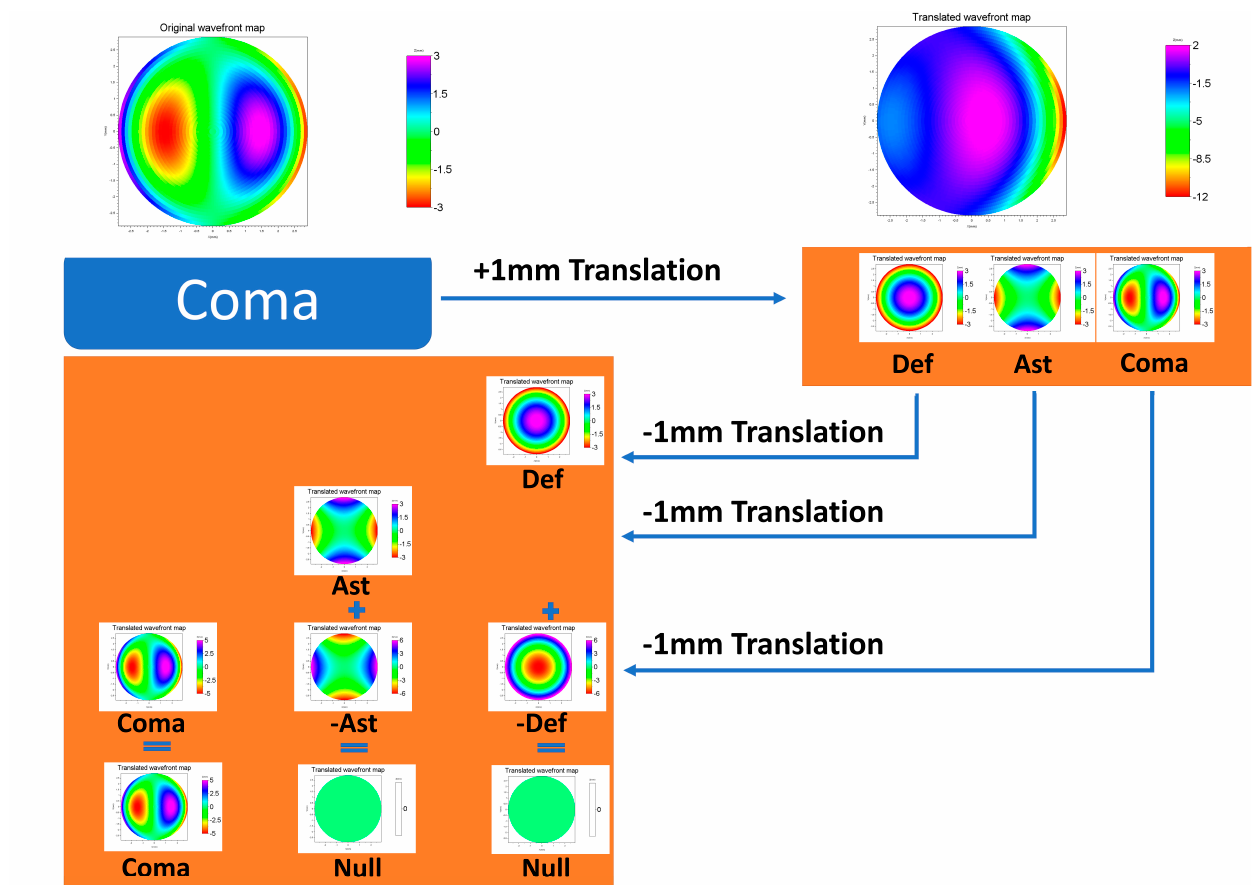
Figure 1. A schematic showing the e ff ect of translation in spherical aberration (Top) and Coma (Bottom). Here, SA is spherical aberrations, Def is defocus, Ast is astigmatism and X represents the translation in horizontal axis with the positive and negative sign convention indicating the direction of translation. A + X translation in SA results in Def, Ast, coma and SA. A − X translation in Def results in the same amount of Def; in Ast results in same amount of Ast; in coma results in negative twice for Def, negative twice for Ast and the same amount of coma; in SA it results in Def, Ast, negative coma and the same amount of SA. Similar relationships can be interpreted for coma translation (bottom). Notice that a combination of all these aberrations resulting from –X translation results in the original higher order aberration (HOA), showing the theoretical equivalence between the e ff ect of the same amount of translation in the positive and negative